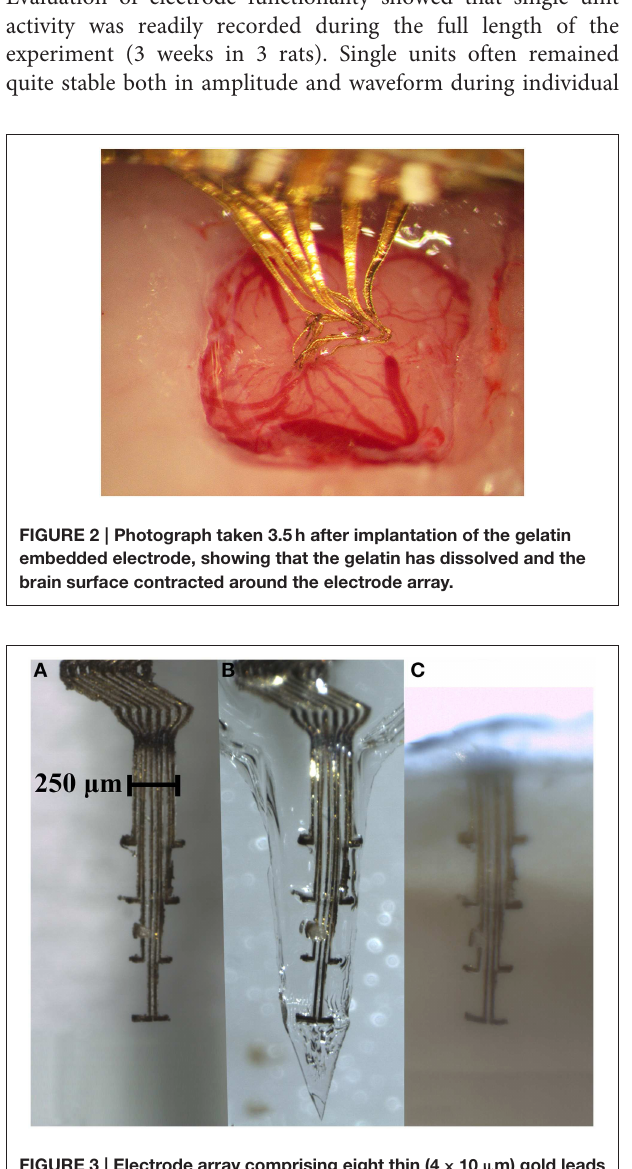
FIGURE 3 | Electrode array comprising eight thin ( 4 × 10 µ m) gold leads insulated with Parylene C, except for an area ( 10 × 10 µ m) at the tip of the 100 µ m long protrusions. (A) An electrode array before embedding into a gelatin based matrix. (B) The same electrode array after being embedded into a gelatin matrix shaped as a needle, and in (C) , same electrode array inside a section of clarified brain tissue 3 weeks post implantation. Note